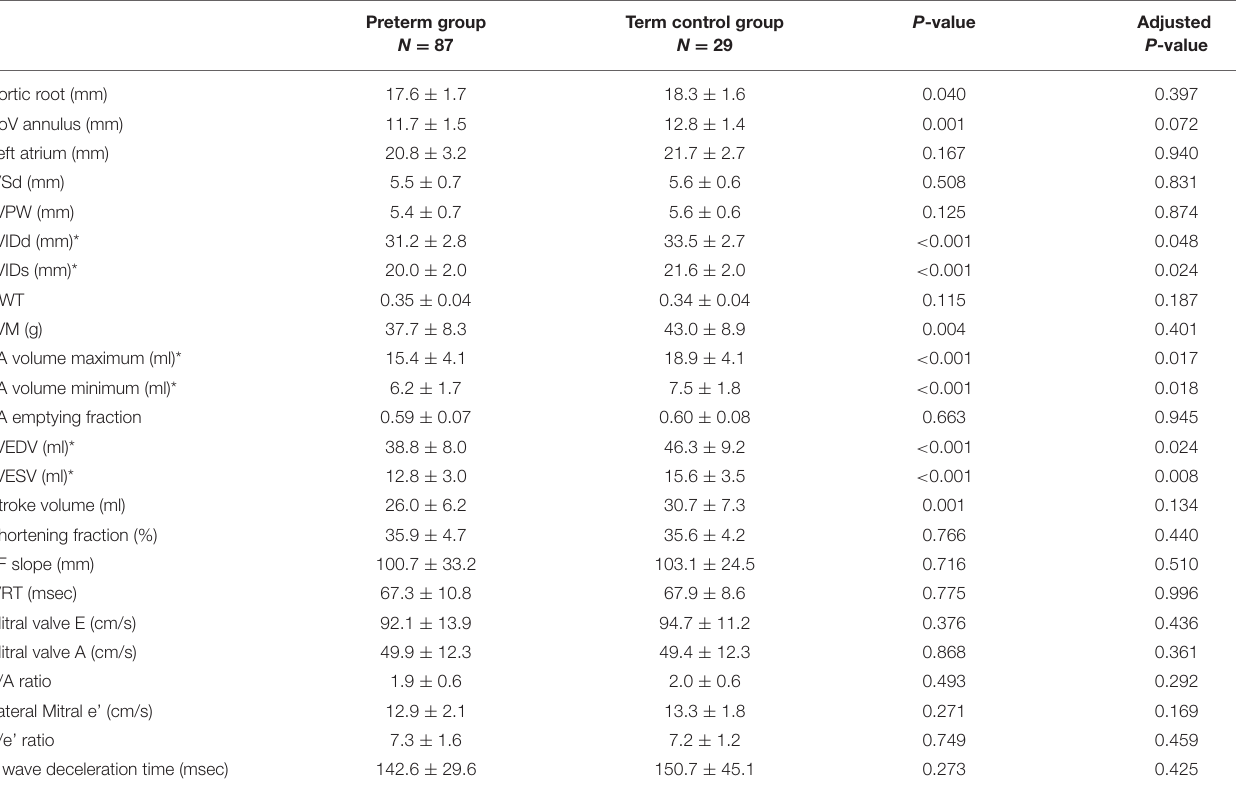
TABLE 3 | Comparison of the conventional echocardiographic results between the preterm group and term control group.